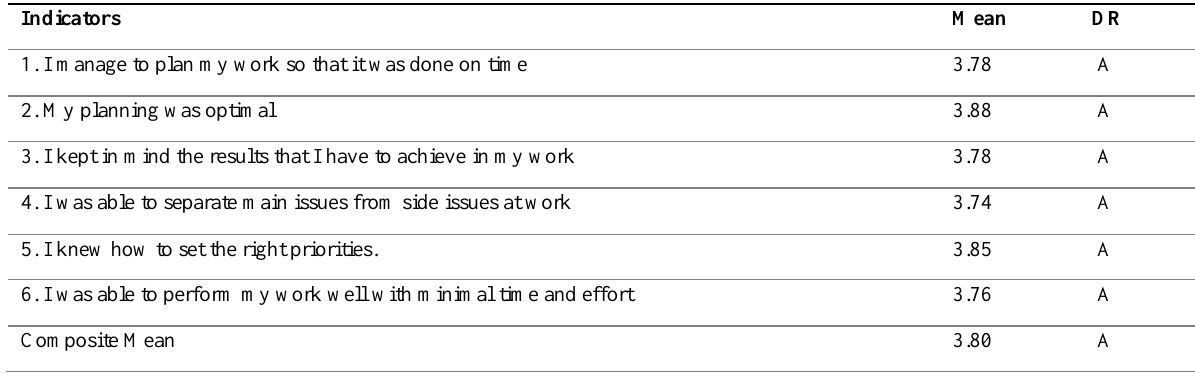
Table 7: Individual Work Performance of Employees in terms of Task Performance